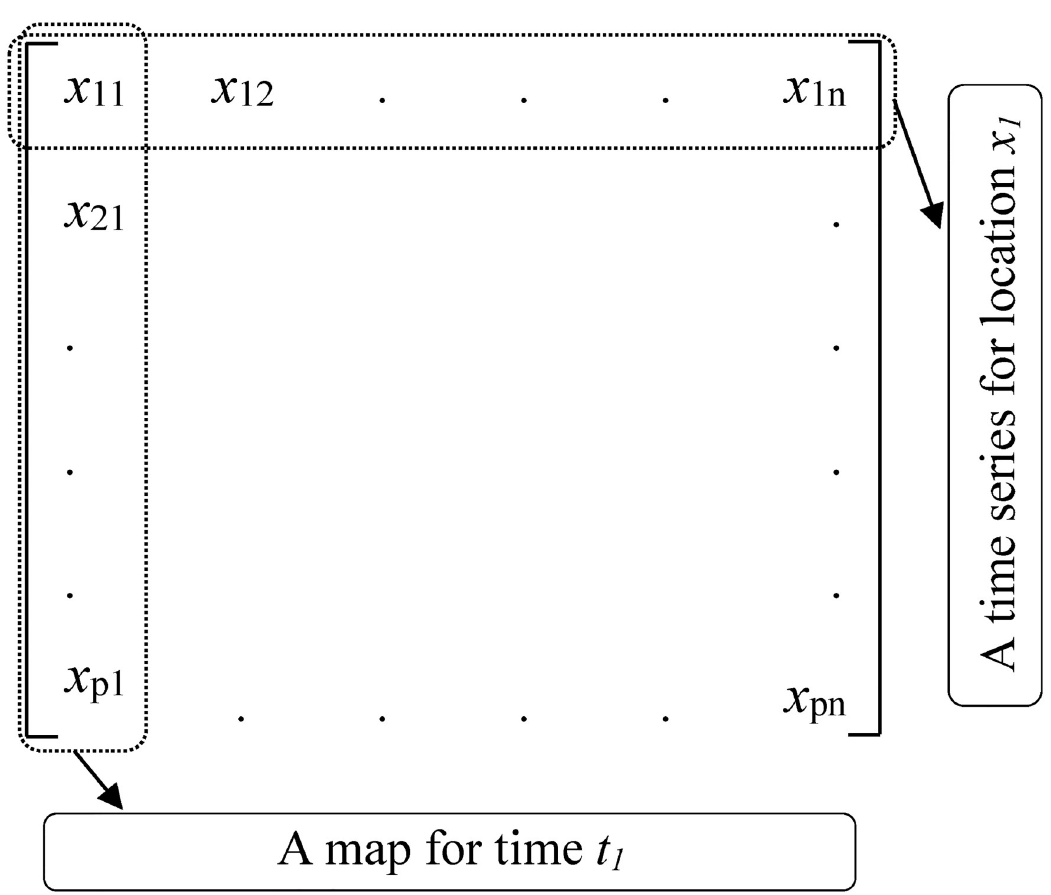
Fig 2. Prepared daily optimum interpolation SST anomaly (DOISSTA) data in matrix format.